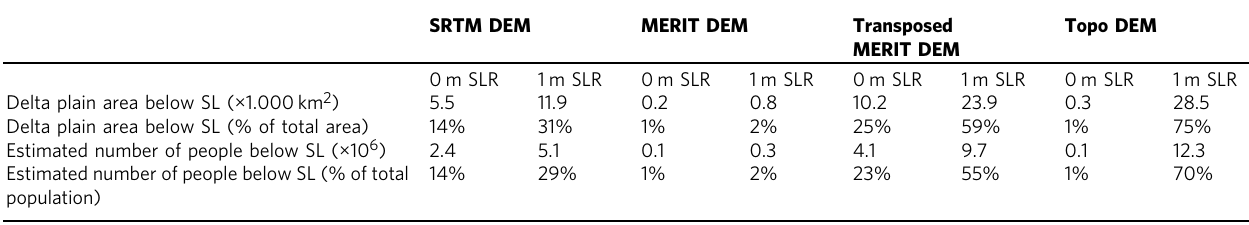
Table 3 Area and estimated people below sea level with 1 m sea-level